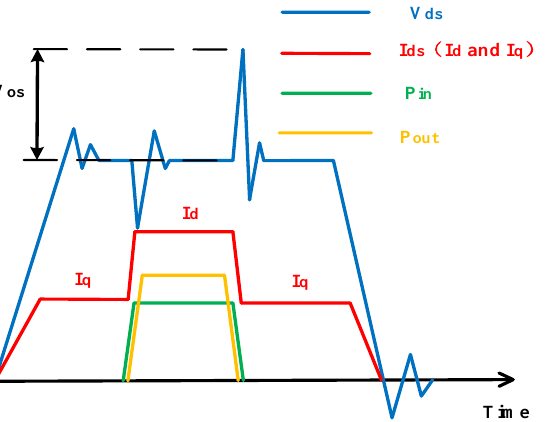
Figure 1. Relationship between the drain voltage, drain current, input power, and output power of the pulsed power amplifier.